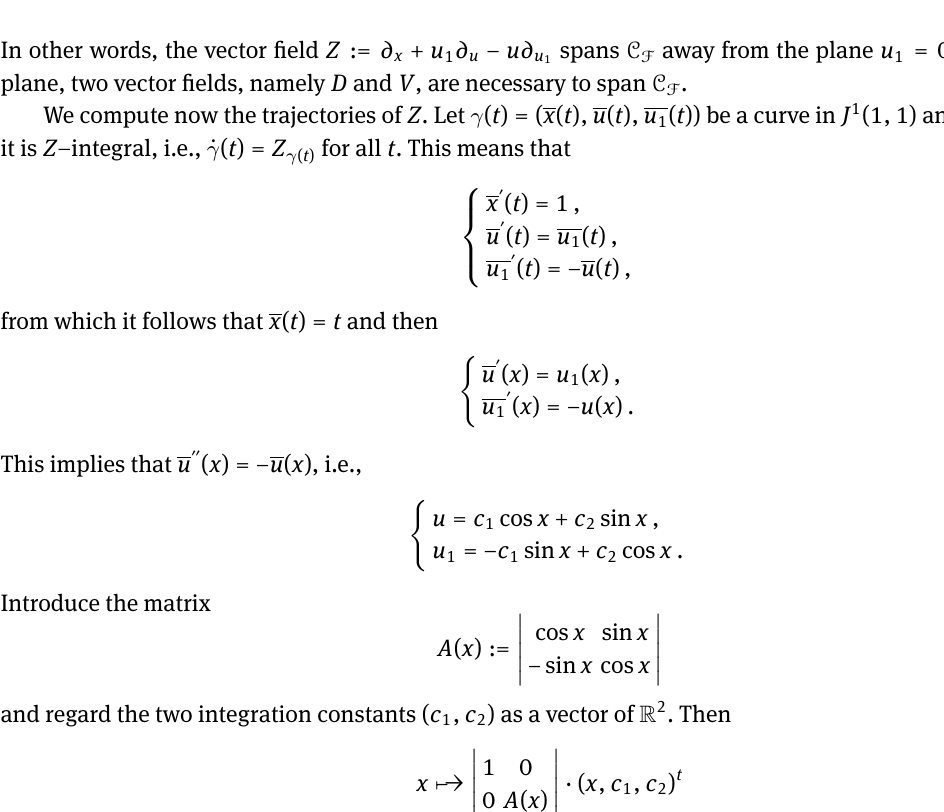
spans C F away from the plane u 1 = 0, while on this 1